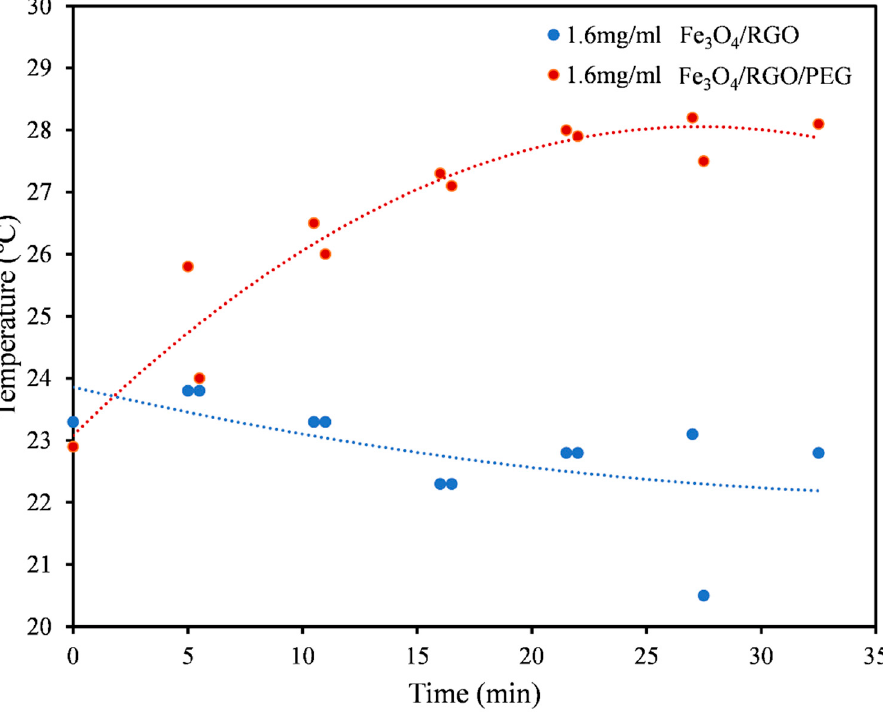
Figure 4. Heating profiles for 1.6 mg/mL solutions of Fe 3 O 4 /RGO (blue) and Fe 3 O 4 /RGO/PEG (red) in PBS medium at magnetic field of 200 A.